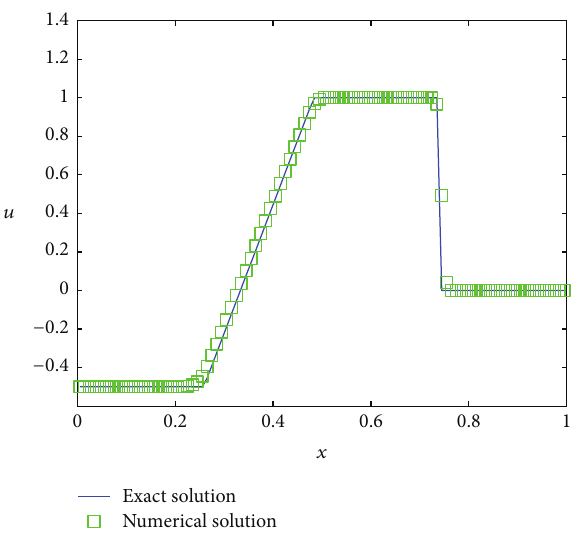
Figure 12: SHA method with TVD applied to inviscid Burgers’ equation for continuous initial value; numerical (symbols)and exact (line) solutions are compared at 𝑡 = 0.15 units.